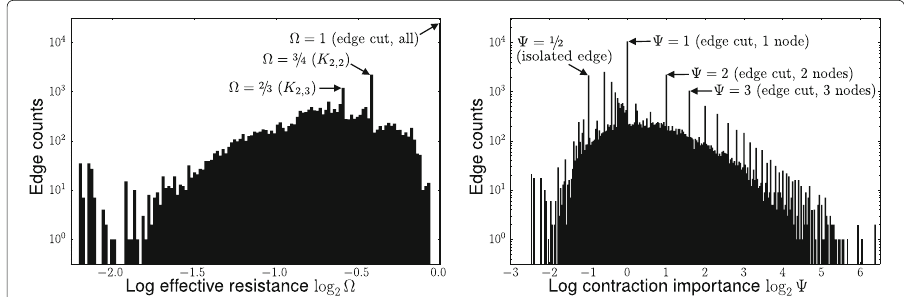
Fig. 6 The distributions of log effective resistance (log 2 (cid:4) ) and log contraction importance (log 2 (cid:5) ) provide information about the connectivity properties of the network. Peaks in the effective resistance at 3/4 and 2/3, correspond to the complete bipartite subgraphs K 2,2 and K 2,3 (i.e., two authors/publications connected to two or three publications/authors), respectively. Peaks in the contraction importance at n ∈ N , correspond to edges whose removal would separate n nodes from the bulk of the network. The counts of such edges in these integer peaks appears to approximately follow a power law (with exponent γ ∼